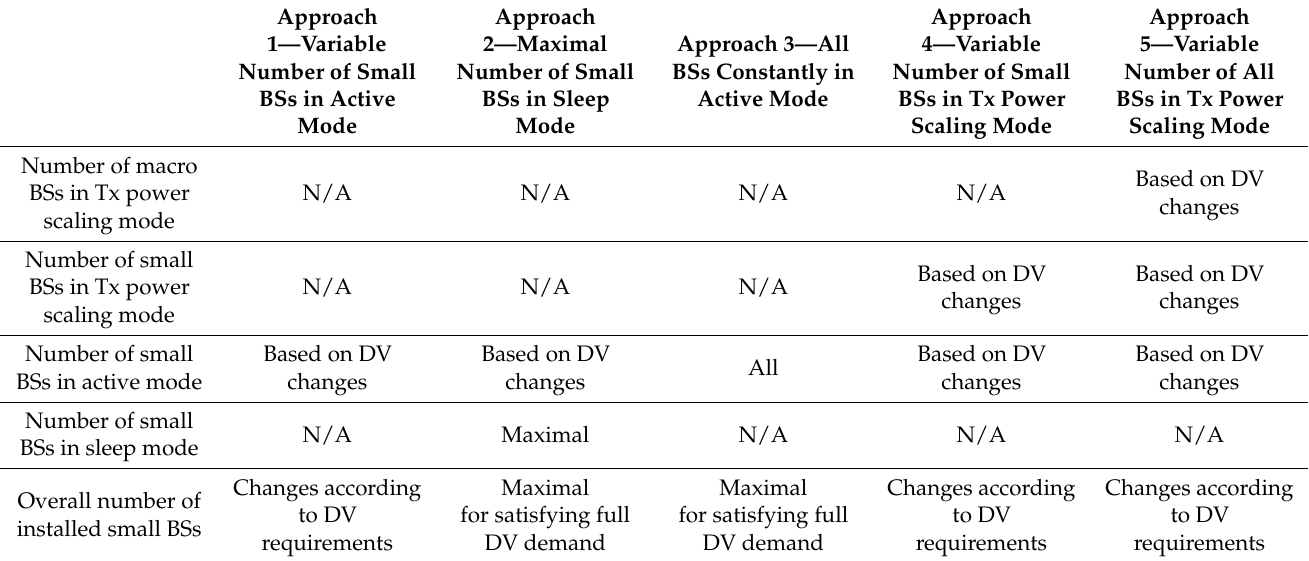
Table 3. Analyzed network deployment and operation